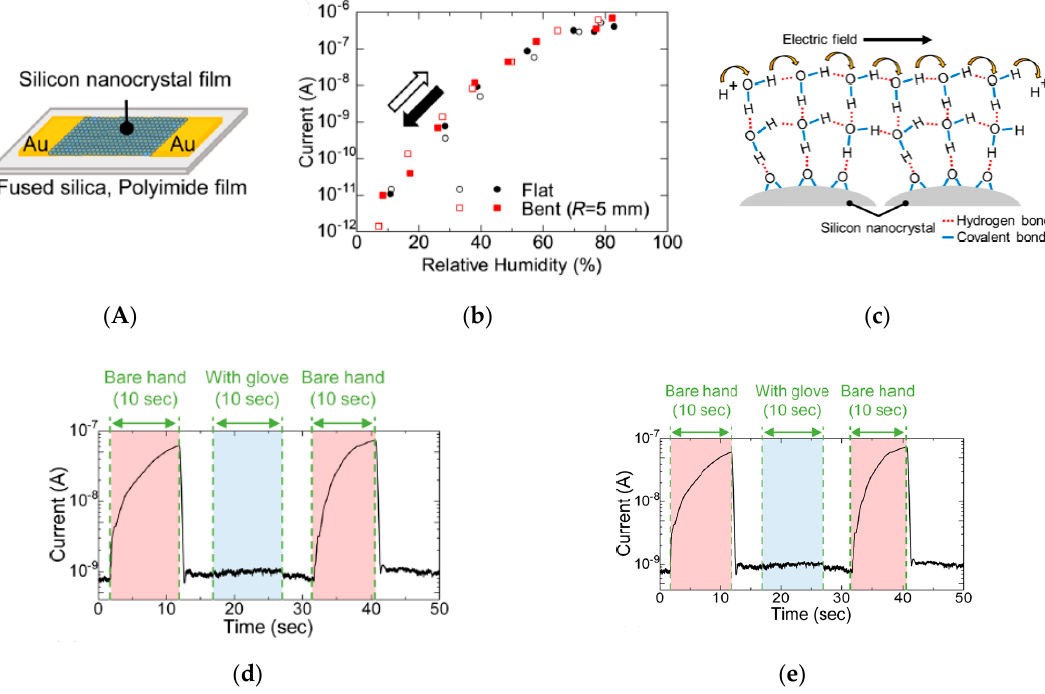
Figure 21. ( A ) Illustration of the Si-NC-based humidity sensor. ( B ) Current of the sensor as a function of relative humidity. Open and filled marks: increasing and decreasing humidity, respectively. ( C ) Illustration of charge carrier transport principle on Si-NC. ( D ) Monitoring of water evaporation from a bare hand skin. ( E ) Real-time detection of water evaporation from a hand. Pink periods correspond to application of a bare hand on the sensor. Reproduced from [67] with permission. Copyright © 2017, American Chemical Society.